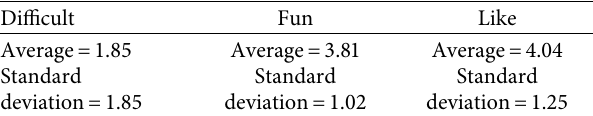
Table 4: Response of a questionnaire to measure users’ responses to